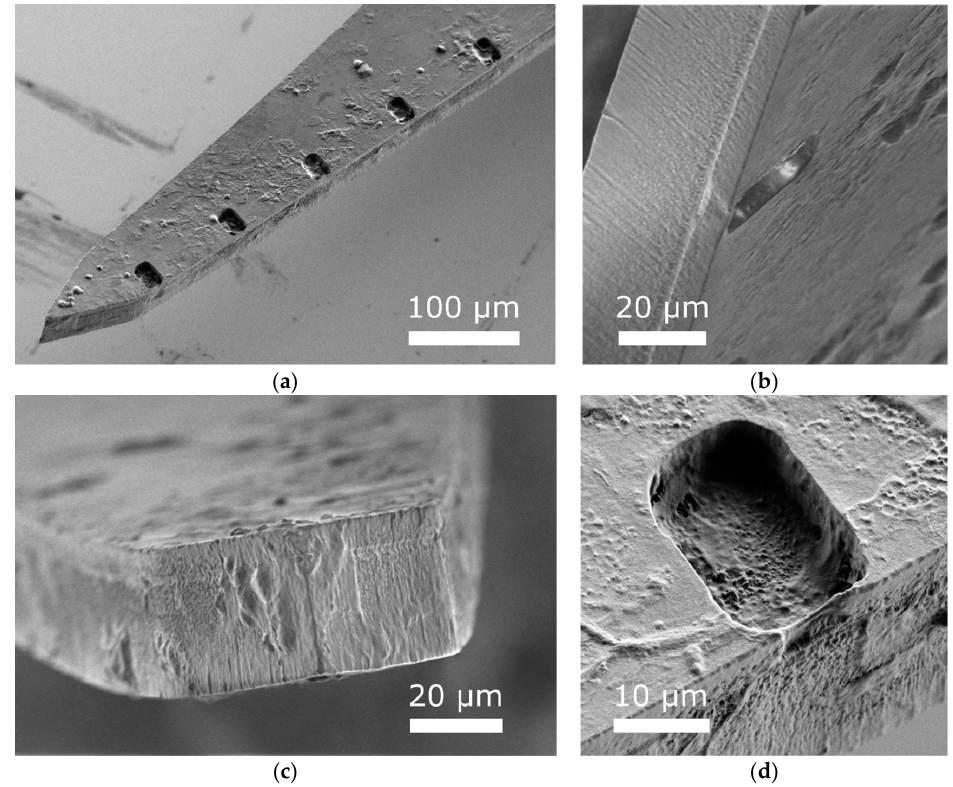
Figure 7. SEM post-explantation. ( a ) Explanted array showing some, but limited, biofouling, ( b ) interface between SMP layers at an electrode site, indicating no apparent layer separation, ( c ) interface between SMP layers at the tip of the array, ( d ) representative electrode site, showing no apparent signs of SIROF delamination.